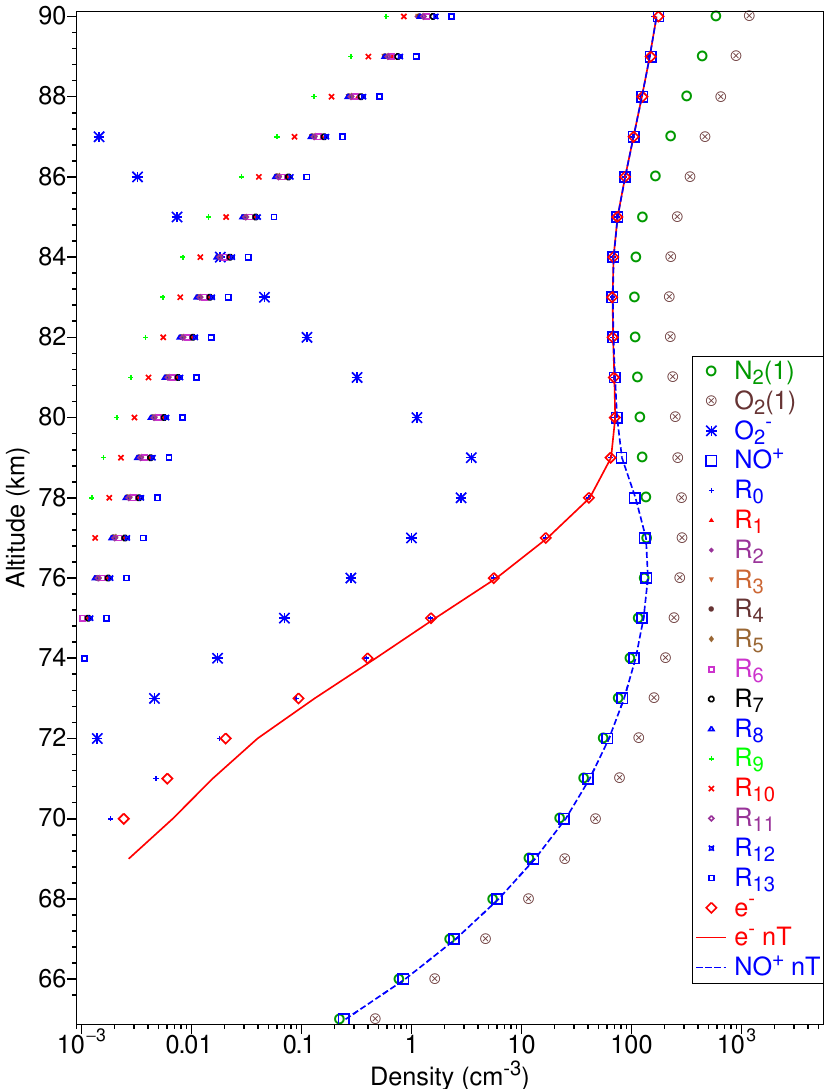
Figure 7. Calculated densities as a function of altitude: electron (—) and NO + (- - -) densities for the nT method; densities for electrons ( ♦ ), NO + ( (cid:3) ), molecules and electron subranges as labelled for the EI method without elastic collisions